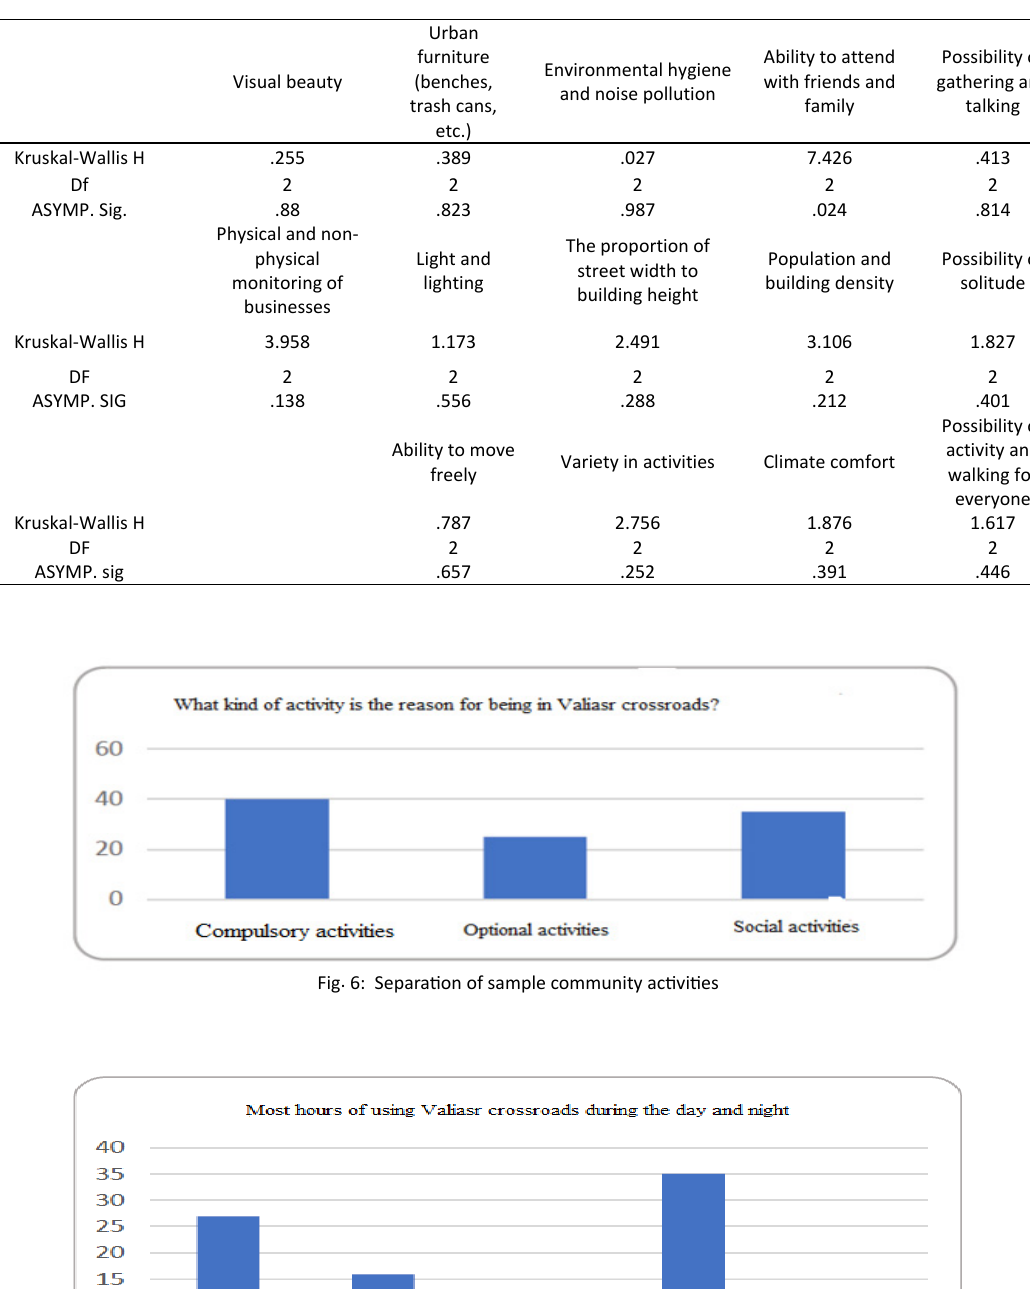
Table 6: Comparison of item rankings in the Kruskal‐Wallis test